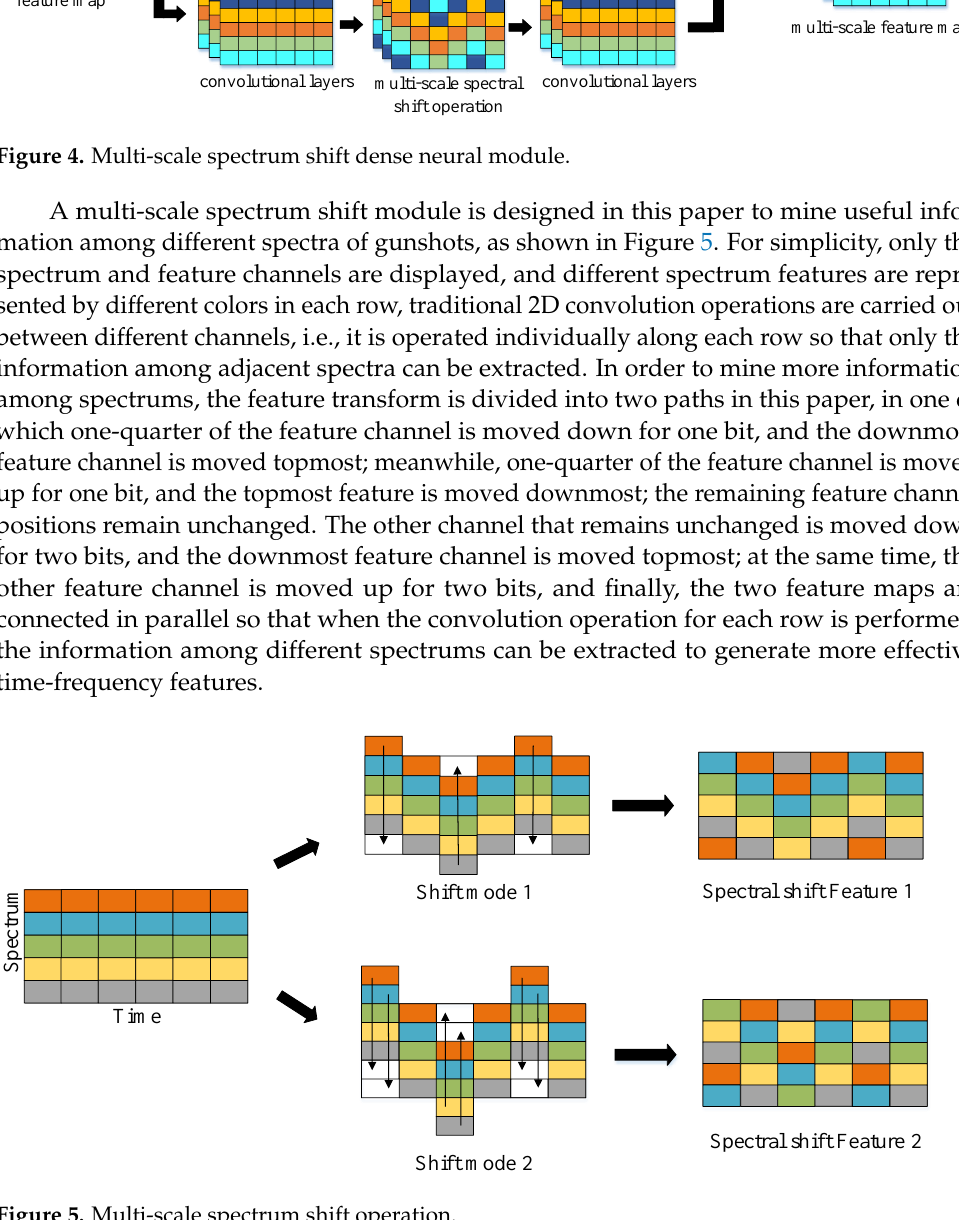
Figure 5. Multi-scale spectrum shift operation.